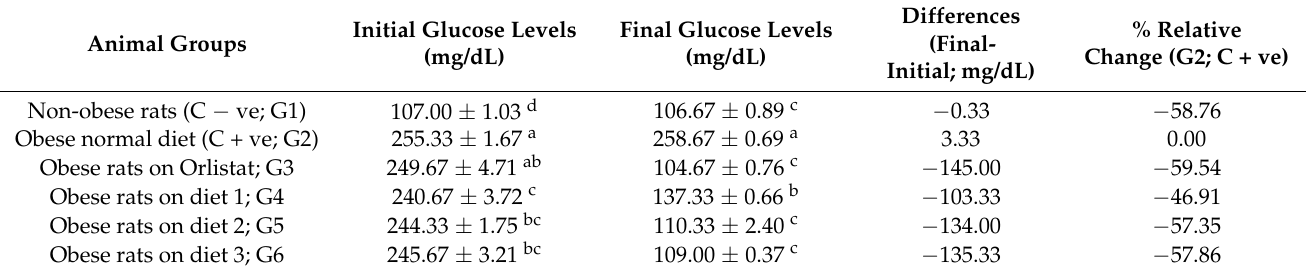
Table 3. Effects of biscuits supplemented with different DF levels on blood glucose levels between obese rats.